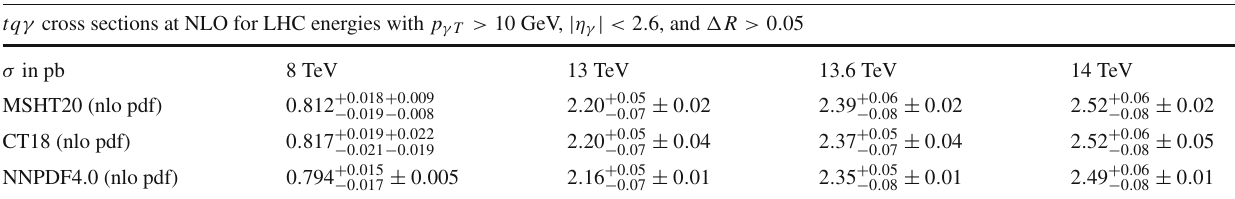
Table 3 The tq γ cross sections at LO and NLO (in pb, with central value for μ = m t with scale and pdf uncertainties, and using cuts p γ T > 10, 15, 20, and 25 GeV, as well as | η γ | < 2 . 6 and (cid:7) R > 0 . 05) in pp collisions with tq γ cross sections at 13.6 TeV LHC energy with | η γ | < 2 . 6 and (cid:7) R > 0 .